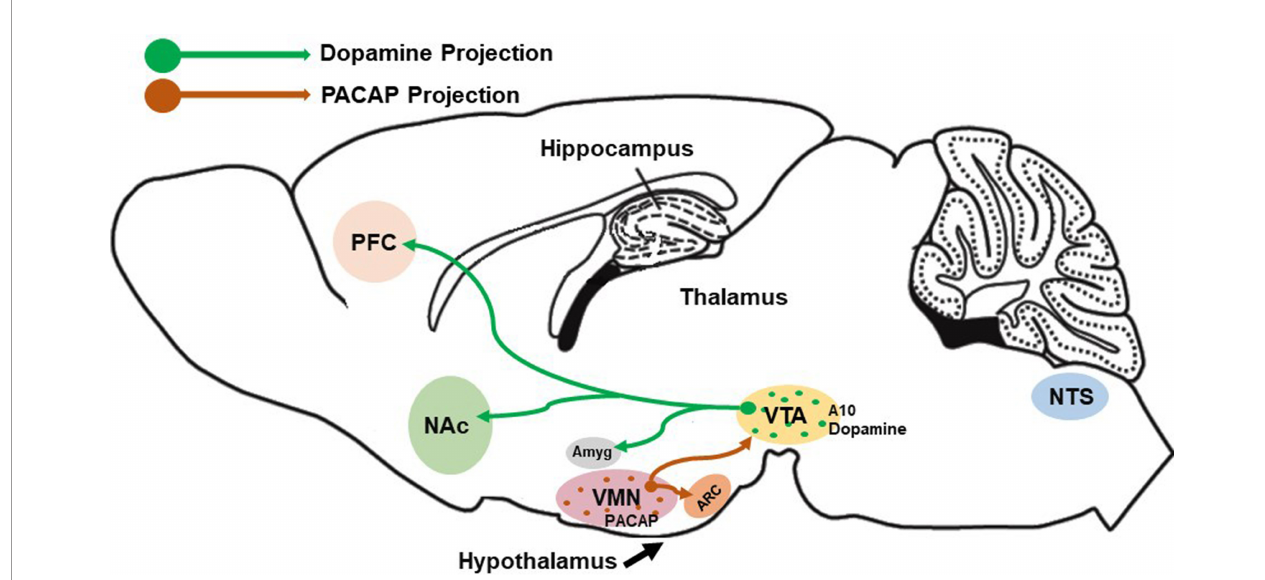
FIGURE 1 | Schematic depiction of VMN PACAP neurons innervating other hypothalamic and mesencephalic structures (e.g., the ARC and VTA, respectively) to regulate homeostatic and hedonic feeding. Postsynaptic targets of these VMN PACAP neurons include POMC neurons and A 10 dopamine (DA) neurons, the latter of which project to regions like the amygdala, nucleus accumbens and prefrontal cortex to regulate executive decision-making based on cues associated with anticipated